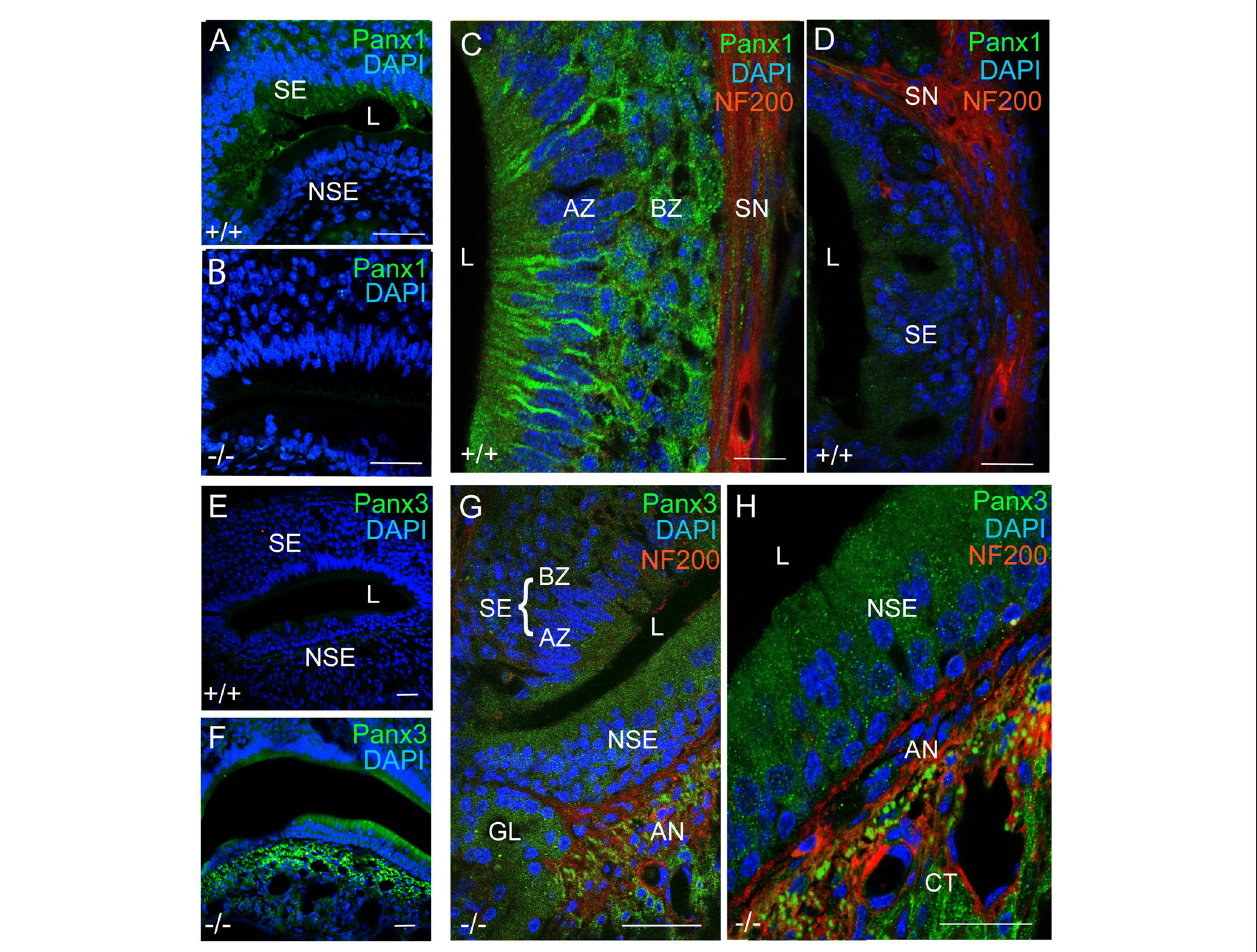
FIGURE 4 | Panx1 and Panx3 protein localization in the VNO of adult mice. (A,B) Overviews showing mPanx1 expression (green) and DAPI staining (blue) in the VNO of wild-type and Panx1 − / − mice. In the adult Panx1, wild-type VNO the mPanx1 protein is detected in the SE layer, with some expression in the NSE layer. The Panx1 − / − VNO showed no mPanx1 staining. Scale bars (A,B) = 200 µ m. (C) In the SE layer of wild-type mice, the mPanx1 protein (green) is localized along tracts of sensory neurons in both AZ and BZ, with some immunoreactivity found in NF200 (red) immunoreactive nerve fibers (SN). The mPanx1 protein showed punctate localization in both the apical zone (AZ) and basal zone (BZ). A very low level of mPanx3 immunoreactivity was detectable in the SE layer, which was dismissed as background (D) Scale bars (C,D) = 50 µ m. (E,F) Overviews include DAPI staining of nuclei (blue) and Panx3 expression (green) in wild-type and Panx1 − / − mice, showing upregulation of Panx3 expression in the VNO of Panx1 − / − mice. Scale bars (E,F) = 100 µ m. At higher magnification (G,H) of VNOs from Panx1 − / −